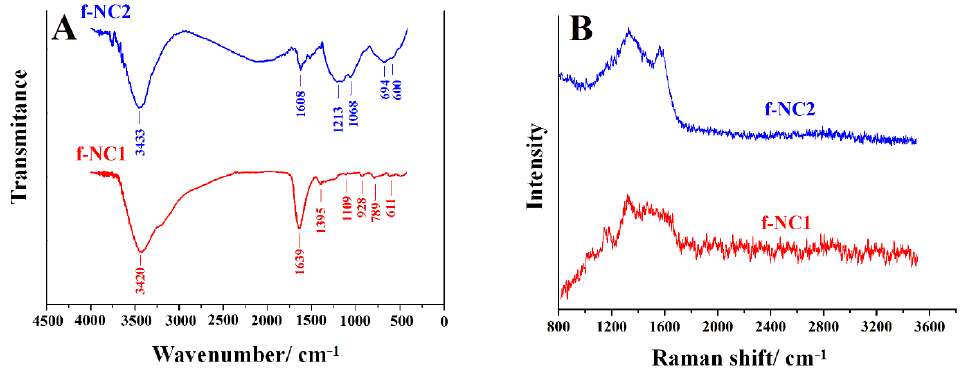
Figure 2. FTIR spectra ( A ) and Raman spectra ( B ) of f-NC1 and f-NC2.